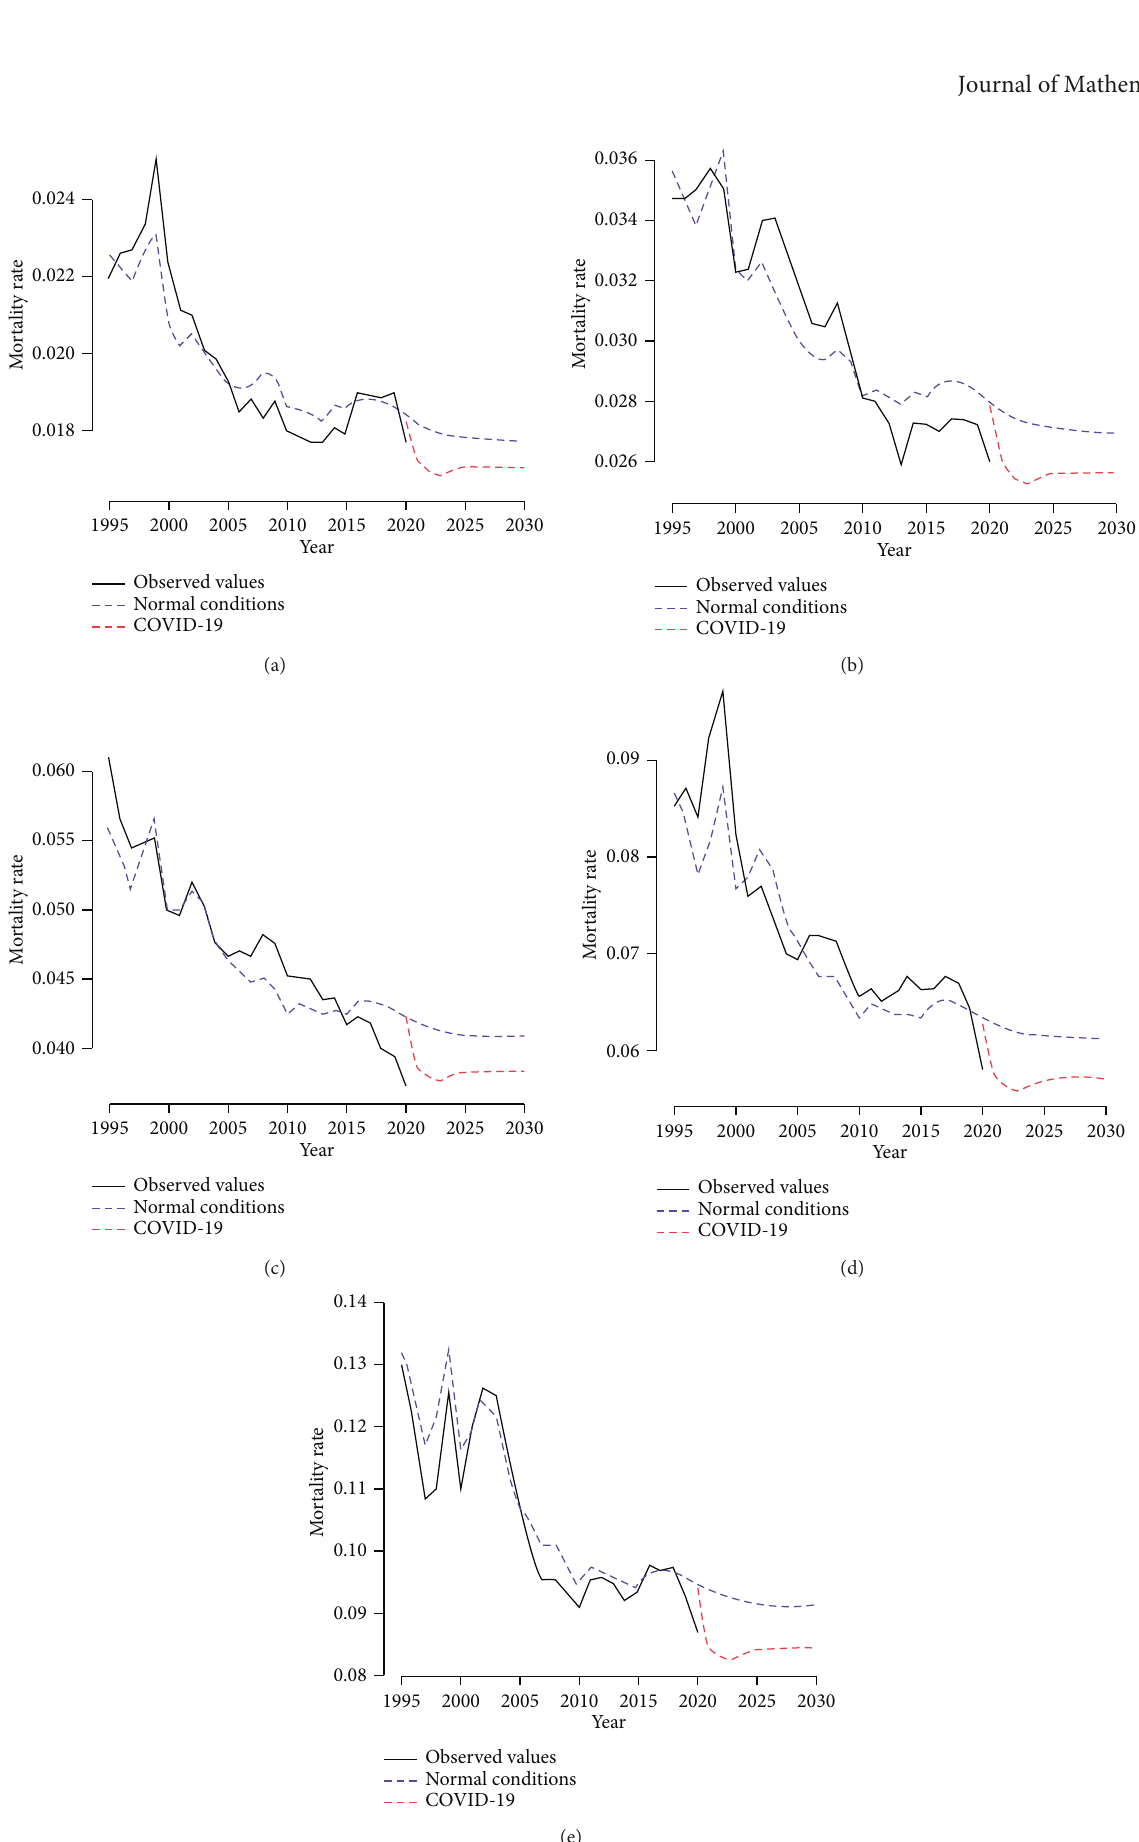
Figure 2: Men’s mortality rate for the age groups of (a) 60–64, (b) 65–69, (c) 70–74, (d) 75–79, and (e)